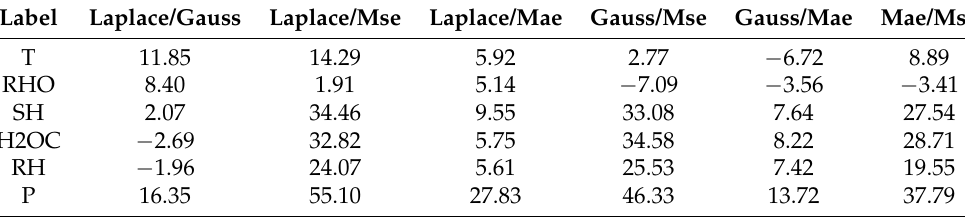
Table 5. Performance comparison of different loss functions on different subtasks.